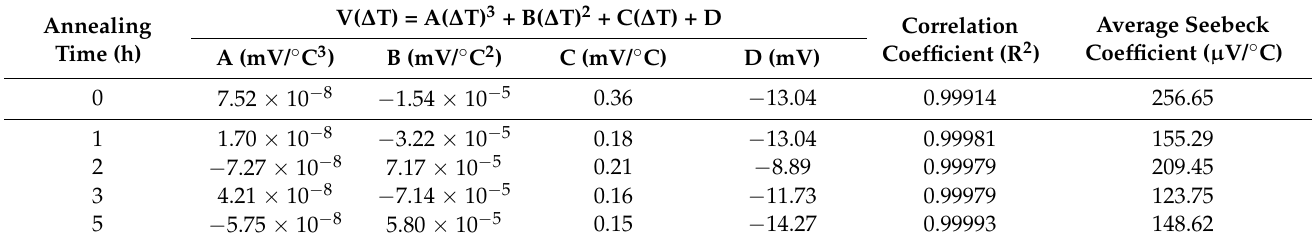
Table 2. Thermoelectric response and fitting results of ITO/In 2 O 3 TFTCs for different annealing